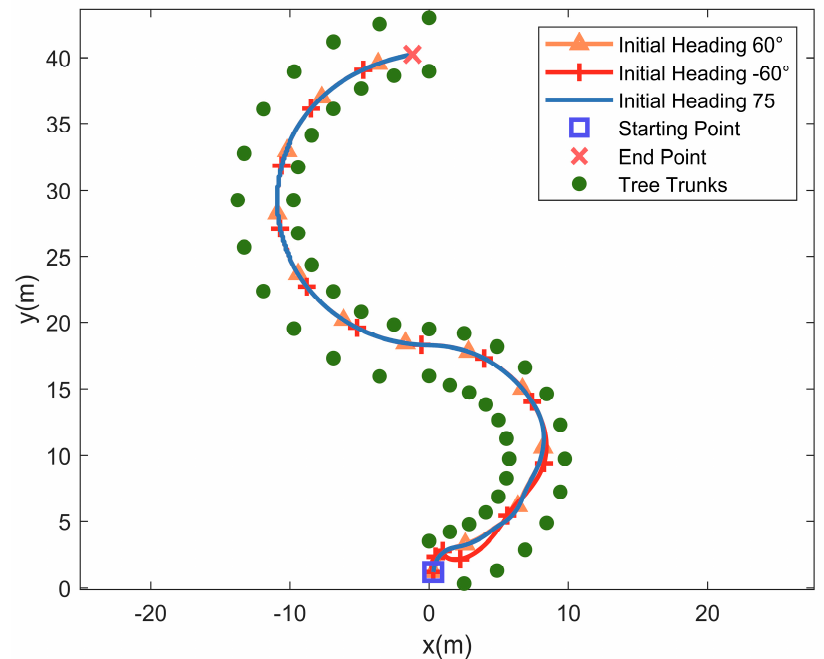
Figure 9. Simulation results of the S–shape path following, with a di ff erent initial heading.